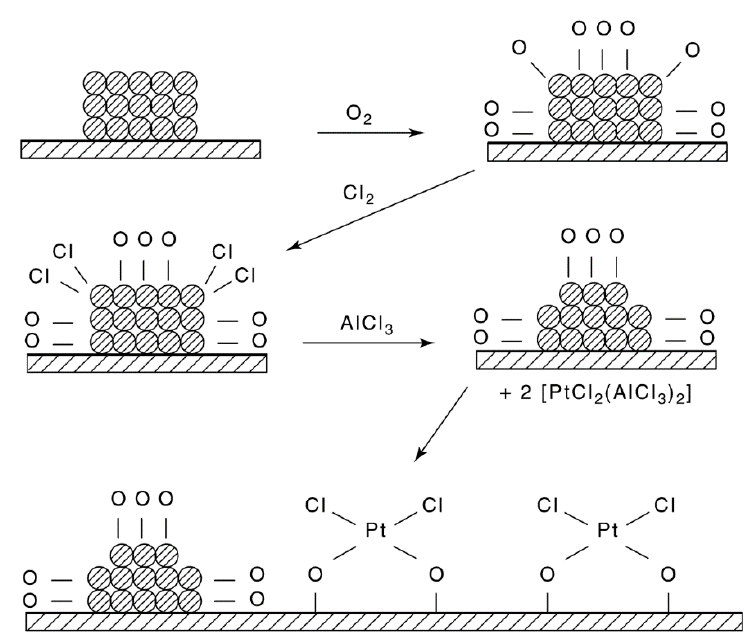
Figure 46. Proposed mechanism for redispersion by oxychlorination of alumina-supported platinum. Reproduced from [256]. Copyright 1982, Brill Nijhoff